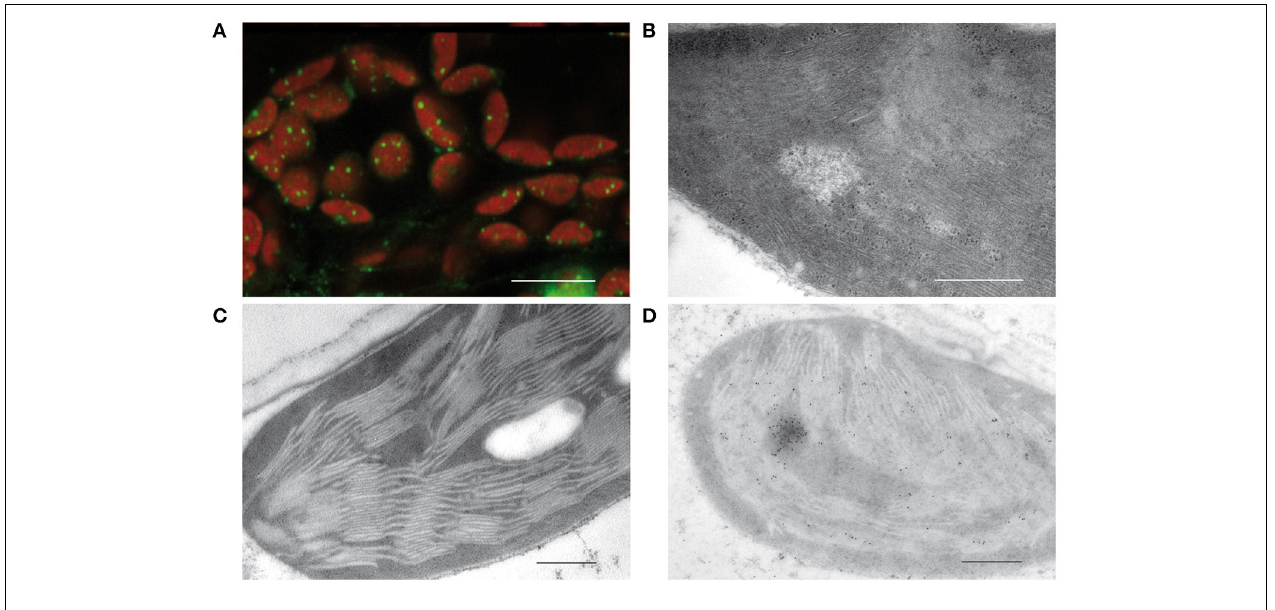
FIGURE 1 | Visualization of plastid nucleoids by using different microscopic techniques. (A) Nucleoids visualized by fluorescence microscopy of SYBR Green in leaf sections, bar: 10 µ m. (B) Conventional electron micrographs showing nucleoids with DNA filaments in mesophyll